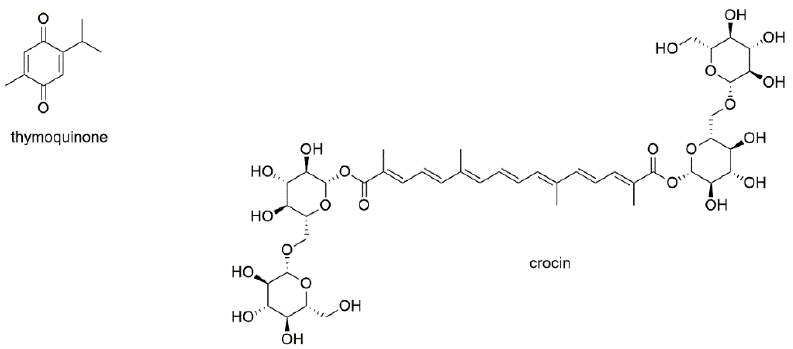
Figure 14. Mono- and tetraterpenes with reported activity against myeloma cell